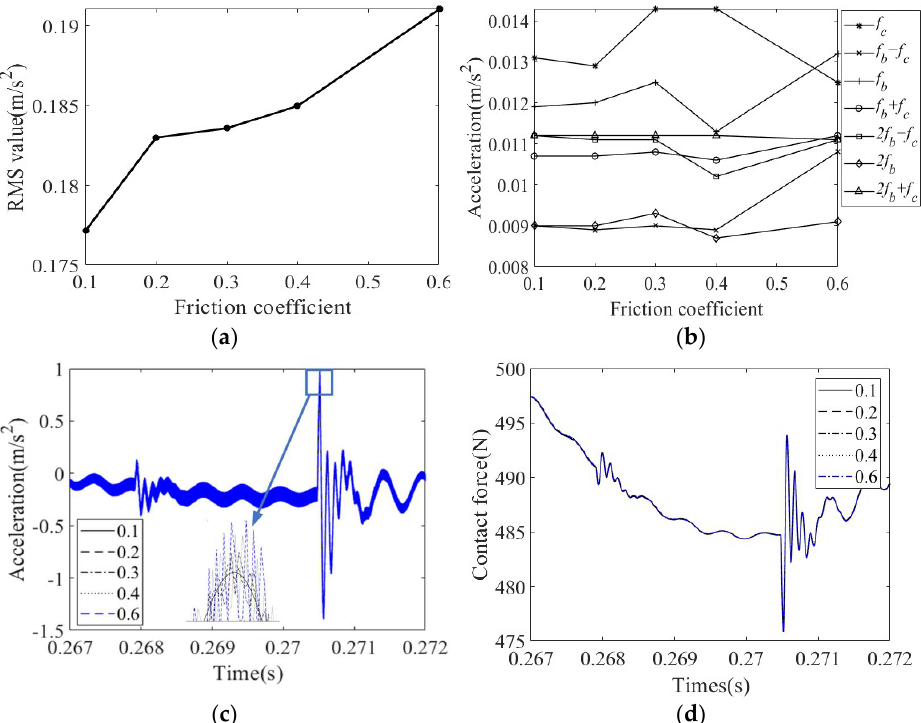
Figure 24. The vibration characteristics of the bearing under roller defect and friction coefficient: ( a ) RMS; ( b ) amplitudes of f c , f b − f c , f b , f b + f c , 2 f b − f c , 2 f b , 2 f b + f c ; ( c ) housing acceleration signal from 0.267 s to 0.272 s; ( d ) contact force between outer ring and housing from 0.267 s to 0.272 s.